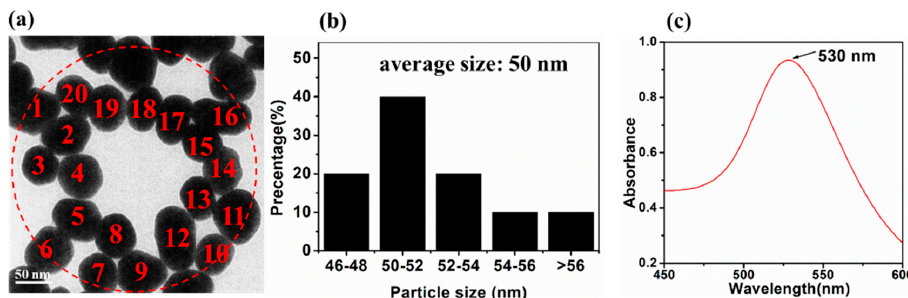
Figure 1. ( a ) The transmission electron microscopy (TEM) images of gold nanoparticles (AuNPs) with heating reaction time at 25 min; ( b ) the distribution of AuNPs; ( c ) the UV–vis spectrometry of AuNPs.